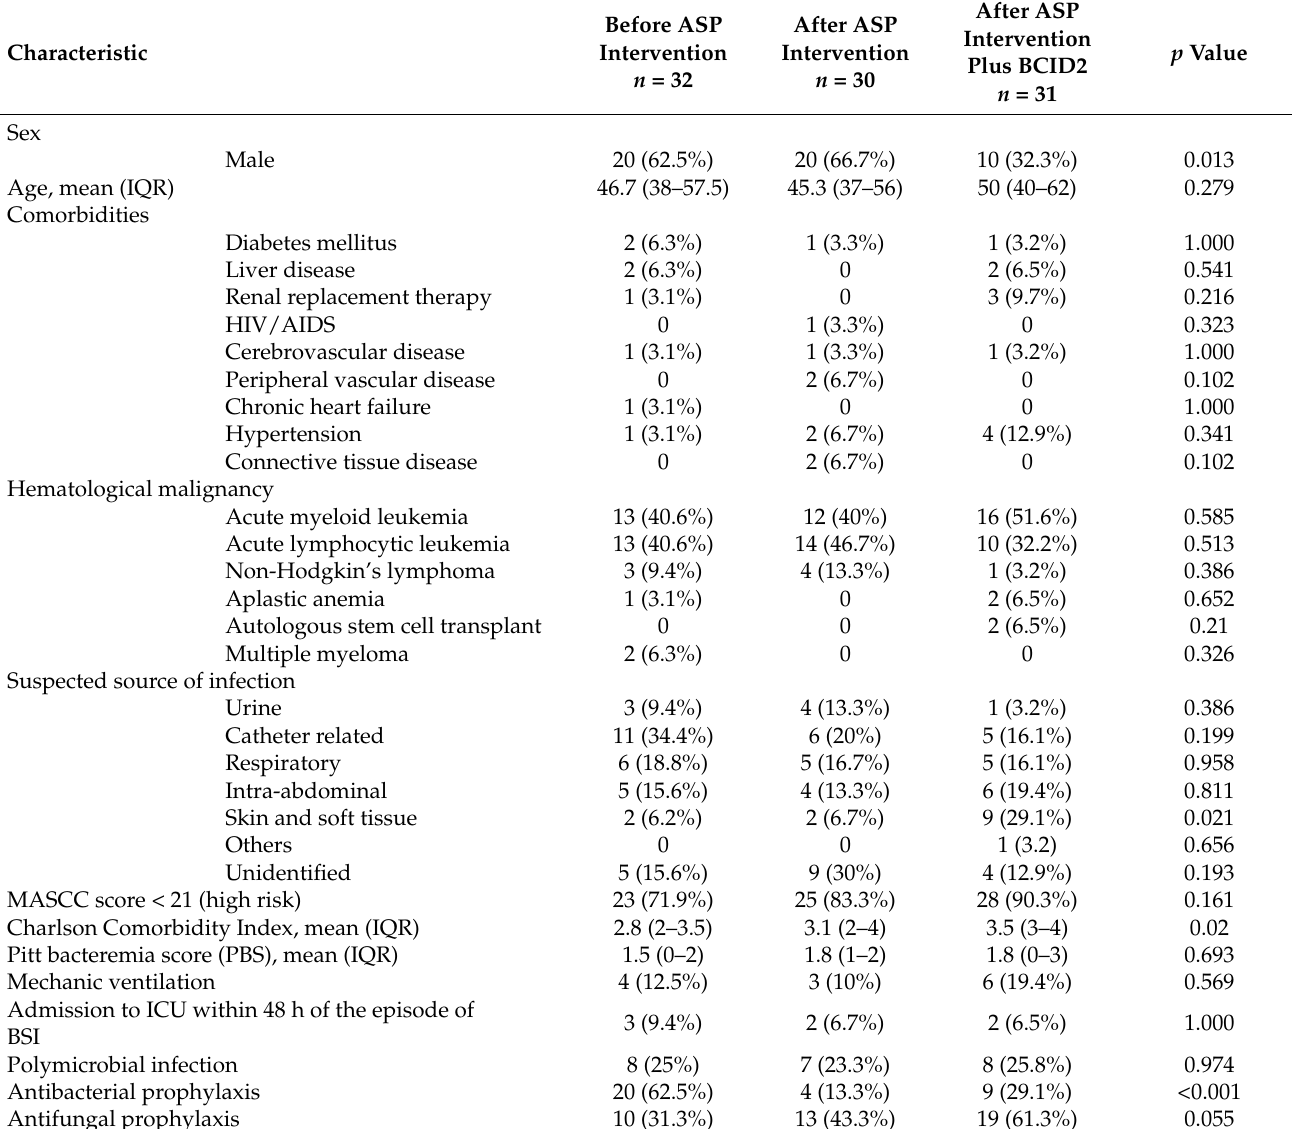
Table 1. Demographics and baseline characteristics of patients with bloodstream